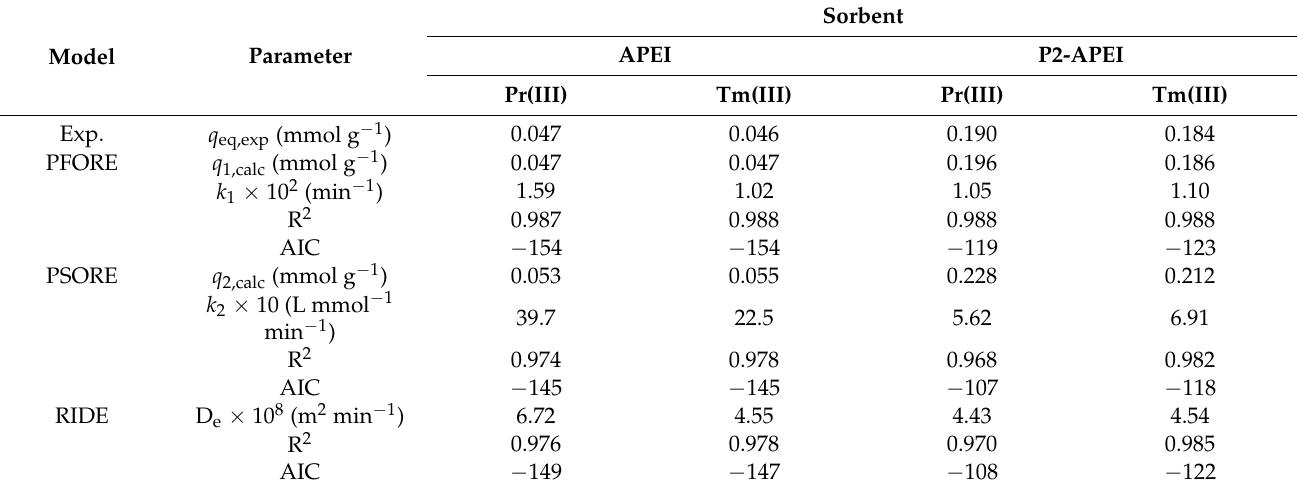
Table 3. Pr(III) and Tm(III) uptake kinetics using APEI and P2-APEI sorbents from binary solutions—fitting parameters for the PFORE, PSORE, and RIDE